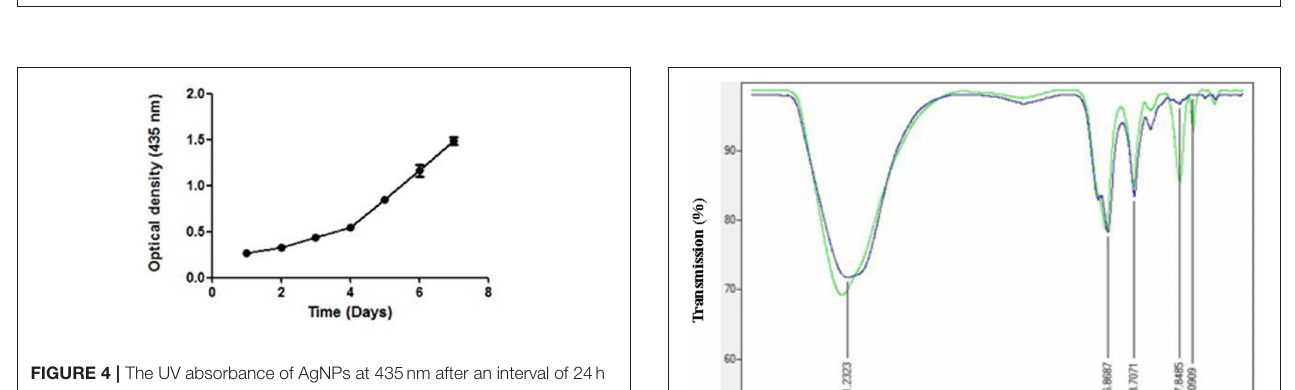
FIGURE 3 | FeSEM images of AgNPs at magnification of (A) 2 µ m, showing the round shape of NPs. (B) proved the round shape of NPs through transmission electron microscopy (TEM) at the scale of 20nm and magnification of 400000 X. A coating around AgNPs is clearly visible indicating toward the surface modifications by AiiA.